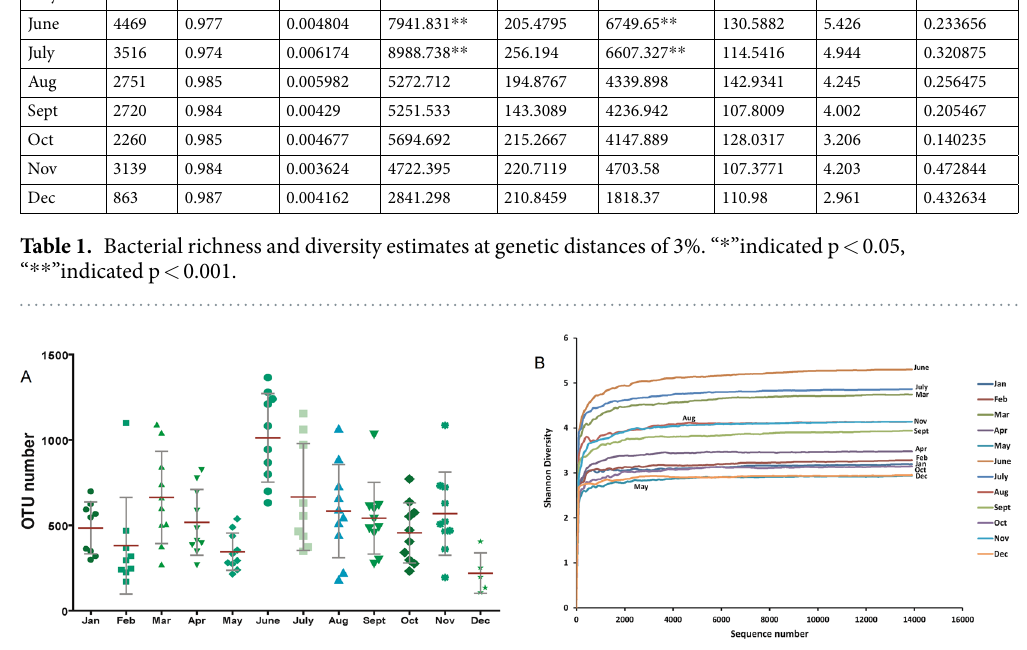
Figure 1. ( A ) Scatter plots showing OTU numbers with respect to total sequences obtained from 16 S rRNA genes associated with months. The error bars were the mean with SD. ( B ) Shannon diversity curve of bacterial community derived from 12